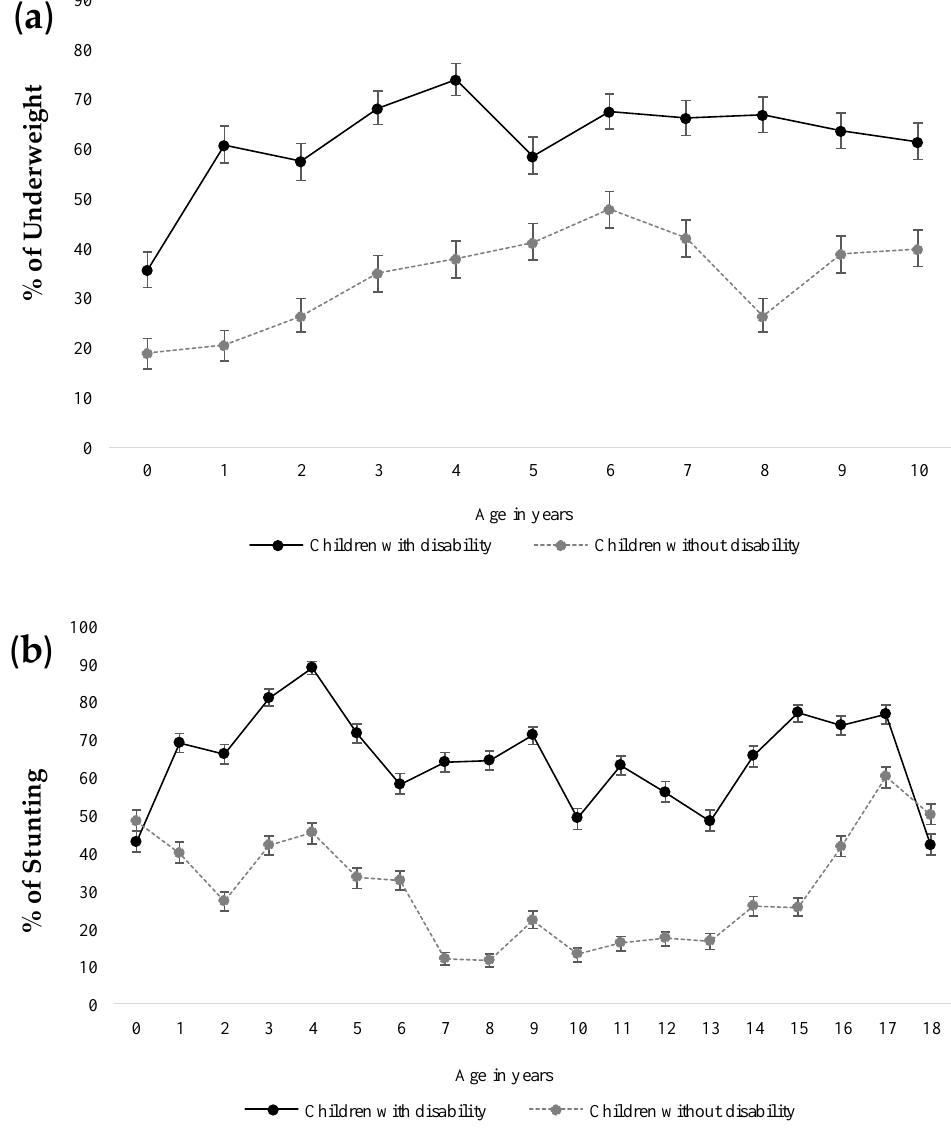
Figure 1. ( a ) Comparison of underweight (%) among children with disability and children without disability according to their age (years). ( b ) Comparison of stunting (%) among children with disability and children without disability according to their age (years).